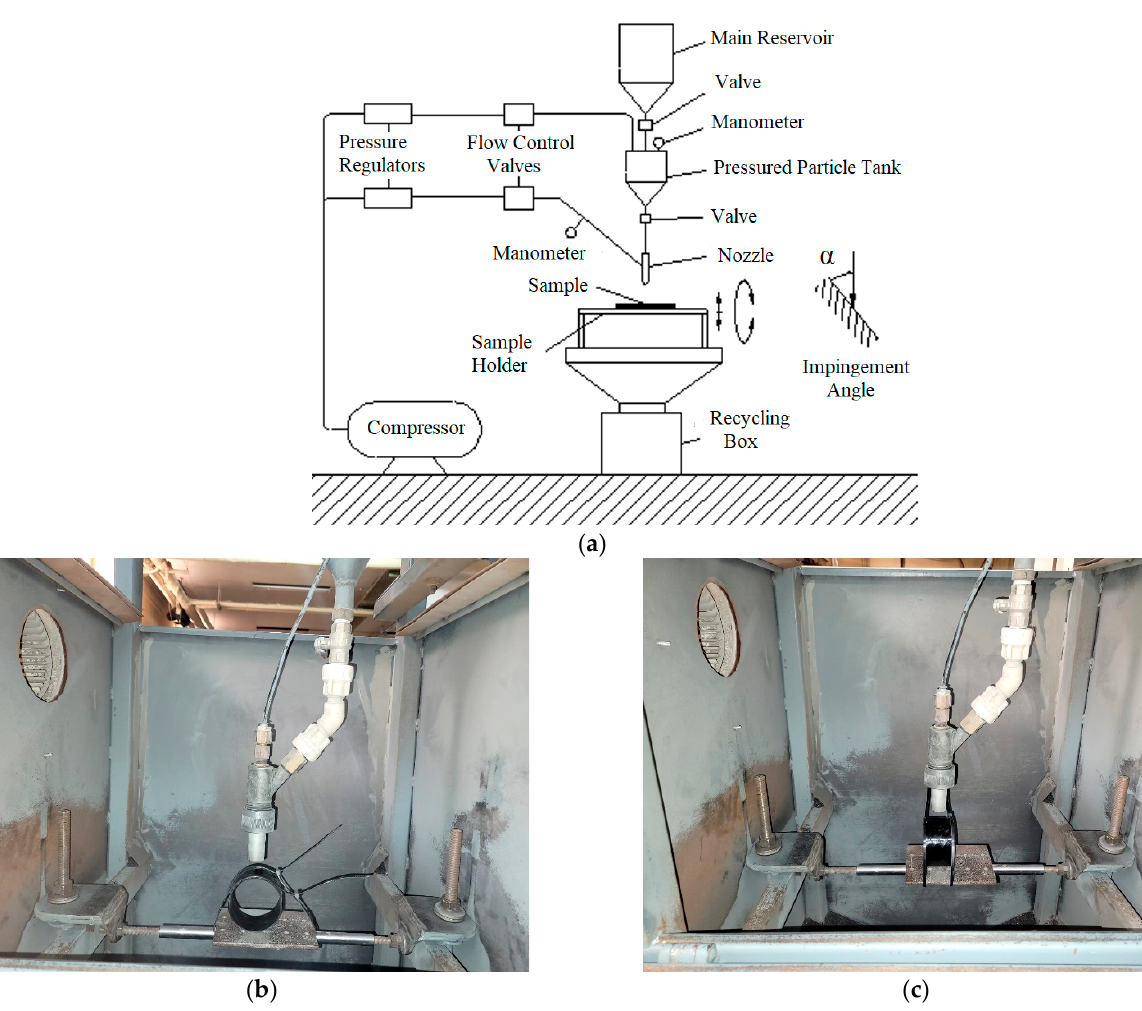
Figure 5. Experimental setup: ( a ) detailed schematic representation of components, ( b ) pipe axial positioning, and ( c ) pipe radial